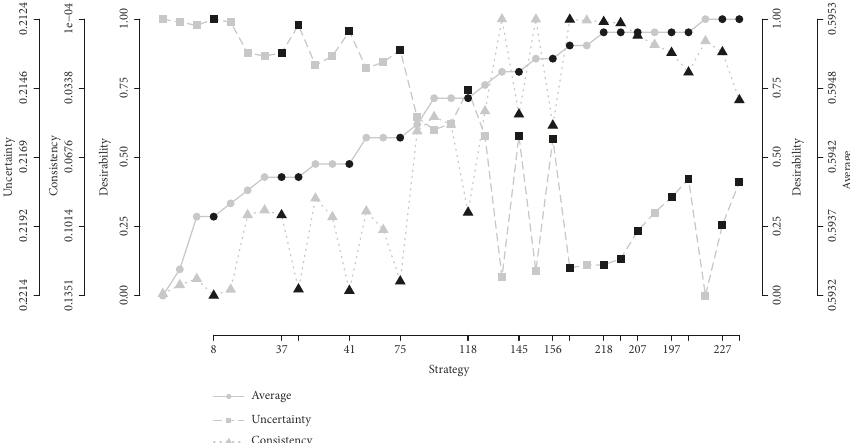
Figure 11: Trade-off plot for comparing the criteria values for the 35 strategies selected in Figure 10. The 16 numbered strategies are displayed in black while the remaining 18 less robust strategies are displayed in light gray. The criteria values are plotted in desirability scale with the original scale shown on the side.